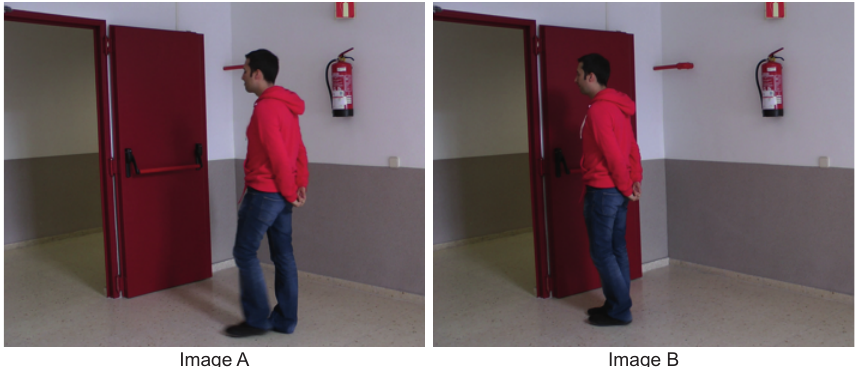
Figure 11. Images used to evaluate the effectiveness of